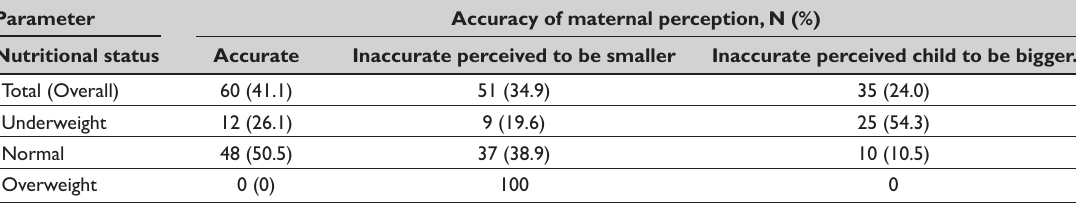
Table 3: Toddler nutritional status, and accuracy of maternal